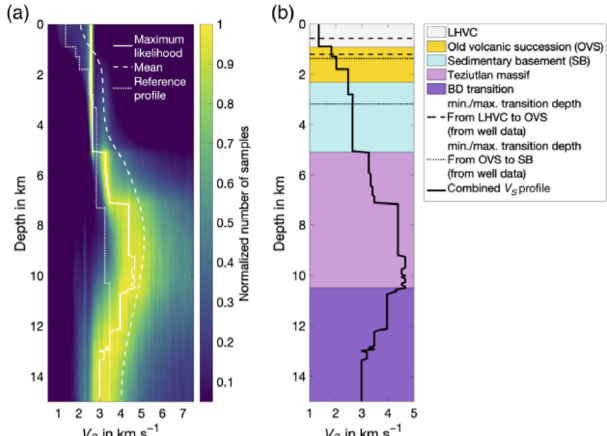
Figure B1. Velocity models used for producing Fig. 3, from Löer et al. (2020). (a) Probability density function (PDF) of shear veloc- ity distribution. (b) Combined shear velocity profile (black) from the analysis of earthquake data (dotted curve in a , down to 3.2km depth) and ambient noise